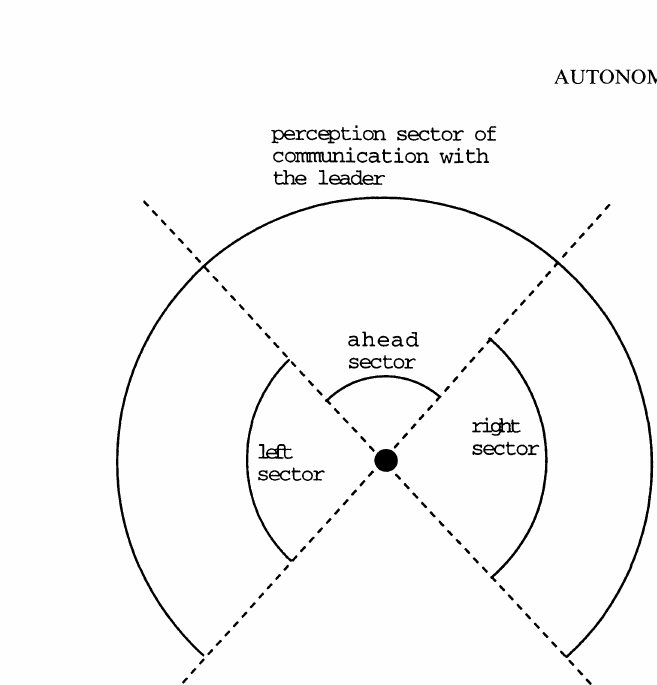
FIGURE The sectors of perception ahead, left, right (with radius Ra, R1, Rr) for the communication between agents, and for the communication with the leader (with radius